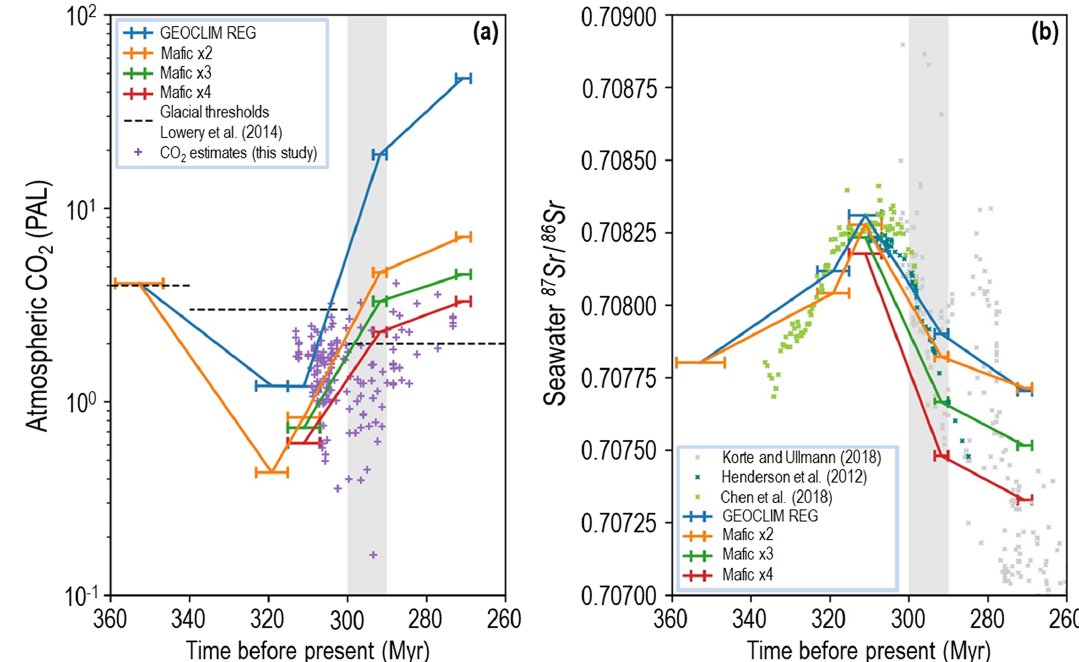
Figure 5. Carboniferous through early Permian modeled (GEOCLIM) steady-state atmospheric CO 2 and seawater 87 Sr / 86 Sr for different surface areas of mafic rocks available for silicate weathering. In the model, maximum geographic extent and altitude (5000m) of the CPM is reached in the Moscovian (320Ma), with altitude decreasing to 3000m at 290Ma and 2000m at 270Ma. (a) Simulated (color lines) and proxy p CO 2 estimates (purple crosses, this study) are shown. Horizontal error bars on the colored lines represent the temporal uncertainty for simulated p CO 2 estimates. CO 2 thresholds for continental ice sheet initiation (360–340Ma = 1120ppm; 340–300Ma = 840ppm; 300– 260Ma = 560ppm from Lowry et al., 2014) decrease in response to equatorward drift of Gondwana, favoring an overall reduction in ice sheet size through time. The reference surface area of outcropping mafic rocks (GEOCLIM REG) maintains steady-state atmospheric CO 2 below the ice initiation threshold from 350 to ∼ 304Ma. Steady-state atmospheric CO 2 for a 2-fold, 3-fold, or 4-fold increase in outcropping area of mafic rocks remains below the ice initiation threshold (560ppm) up to ∼ 300Ma, crossing over at progressively later times in the early Permian. Threshold crossover of steady-state CO 2 at ∼ 290Ma for a 4-fold increase in mafic rock exposure coincides with the termination of the 10Myr CO 2 nadir (gray vertical bar; both panels). (b) Seawater 87 Sr / 86 Sr modeled for the same set of varying surface areas of outcropping mafic rocks and 87 Sr / 86 Sr values of well-preserved biogenic calcites (gray X’s) and conodont bioapatites (green and blue X’s). Horizontal error bars on the colored lines represent the temporal uncertainty for modeled seawater 87 Sr / 86